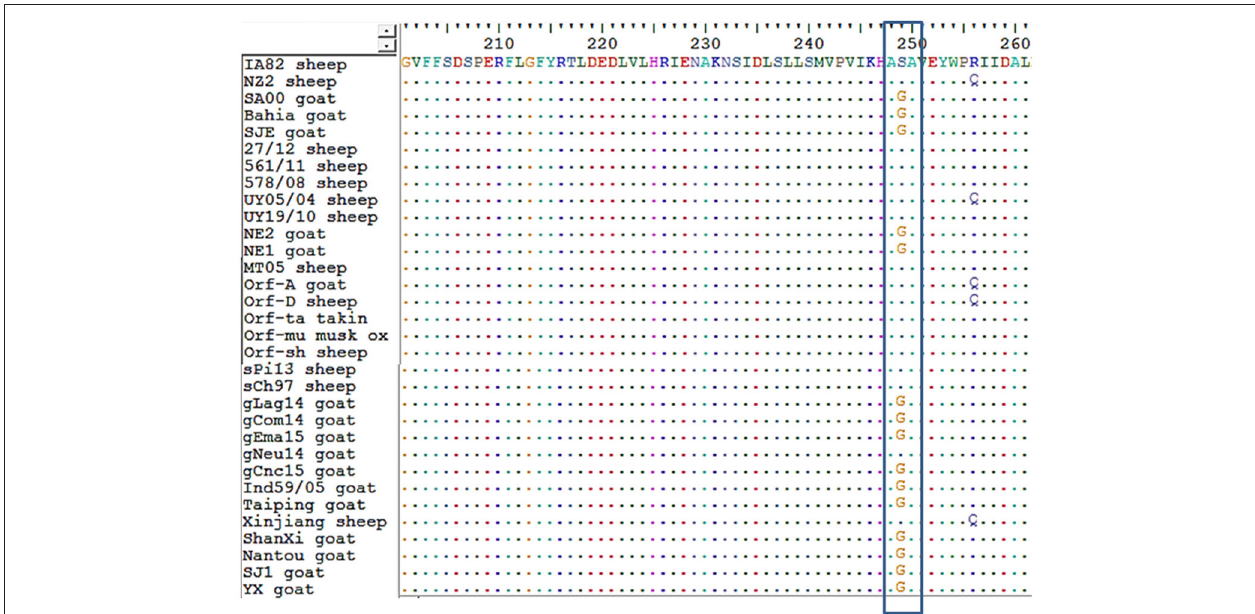
FIGURE 4 | Alignment of amino acid sequences from orf011 . An alignment of amino acid sequences was performed for all strains of ORFV analyzed in the orf011 phylogenetic tree. In the box, position 249 is shown.